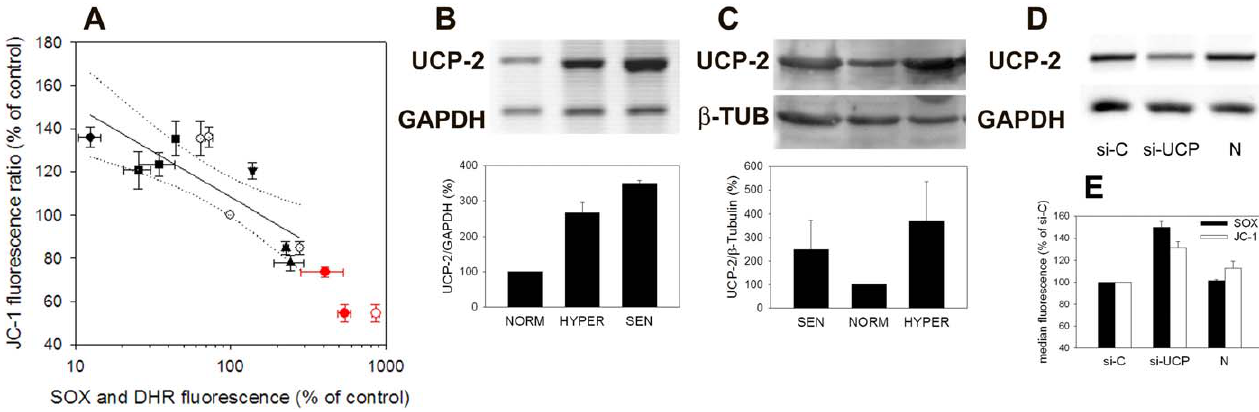
Figure 2. Cellular ROS Levels Control MMP via UCP-2 Expression (A) Interventions that modify ROS result in an inverse change in MMP. Fibroblasts were grown under 5% (squares) or 40% (triangles) oxygen. Cells were also treated with the ROS scavenger PBN (cross-haired square and inverted triangle) or transfected with an SOD3 transgene [34] (diamond). Open symbols: MitoSOX, filled symbols: DHR. Controls (circles) were set as 100% for each experiment. Data are mean 6 s.e.m from three to five experiments per treatment. Solid line: linear regression, dotted lines: 95% confidence intervals. Red symbols: senescent and SES MRC-5 fibroblasts. (B) UCP-2 expression in MRC-5. Top: Duplex-RT-PCR of UCP-2 versus GAPDH. Bottom: quantification of results, n ¼ 2, mean þ difference between means ( D m). NORM indicates young controls proliferating under normoxia, HYPER indicates young cells under 40% hyperoxia, and SEN indicates senescent cells under normoxia. (C) UCP-2 versus b -tubulin ( b -TUB) protein content. Top: Immunoblots; bottom: quantification of results. Data are mean þ D m, n ¼ 2. (D) Suppression of UCP-2 expression in MRC5 fibroblasts by treatment with siRNA (si1-UCP), but not with a scrambled control siRNA (si-C) as measured by RT-PCR. N indicates untreated control. (E) si1-UCP expression results in increased mitochondrial superoxide levels (SOX) and increased MMP (JC-1 ratio). Data are mean þ D m, n ¼ 2. Similar results were obtained with si2-UCP and si3-UCP.